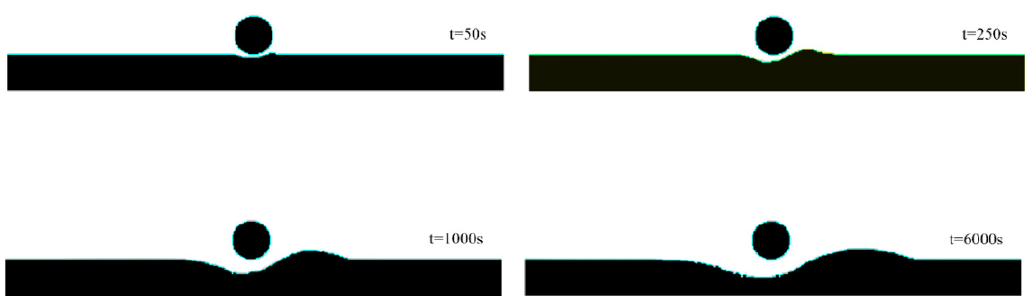
Figure 5. Terrain and depth changes in scour processes.